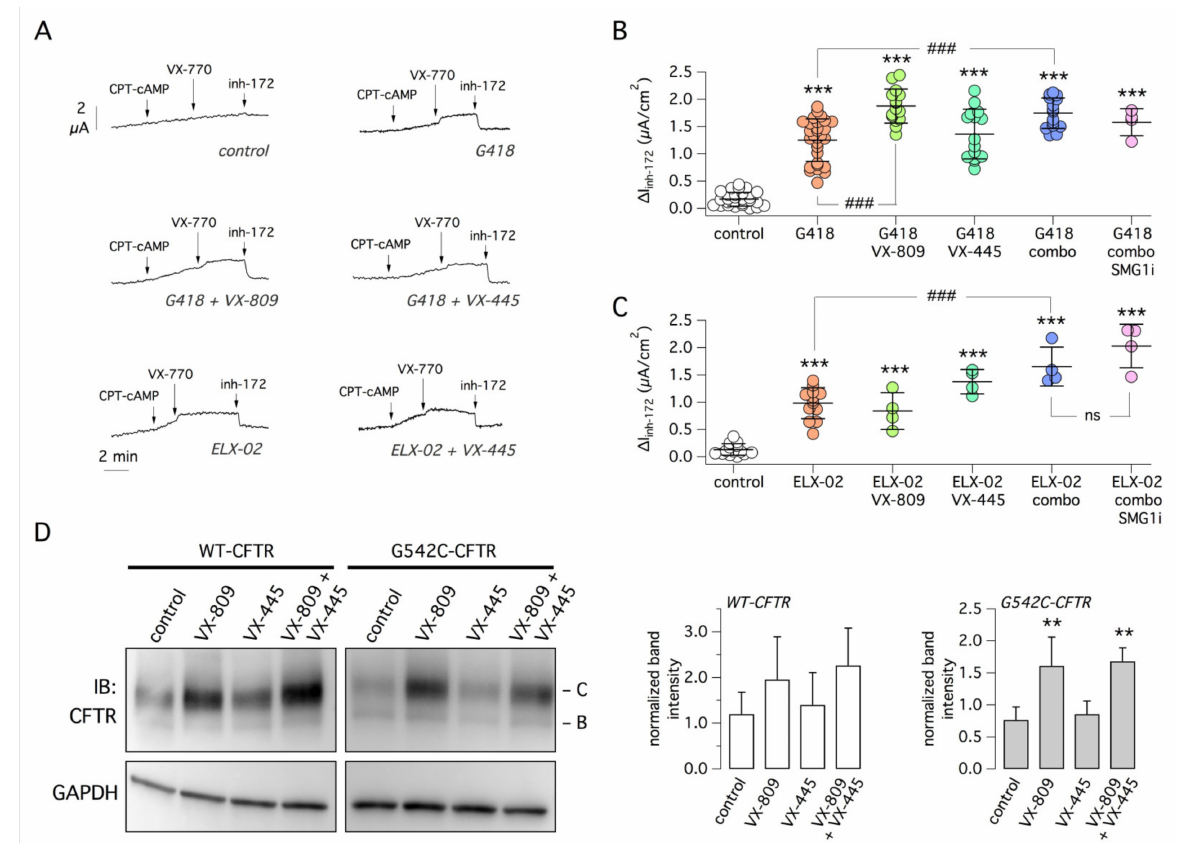
Figure 1. Pharmacological rescue of G542X-CFTR mutant. ( A ) Representative short-circuit current recordings from the 16HBE14o- bronchial epithelial cell line carrying the G542X mutation in the CFTR gene. Before recordings, cells were treated for 24 h with G418 (0.5 mg/mL) or ELX-02 (0.5 mg/mL) alone or in combination with VX-809 (1 µ M), VX-445 (5 µ M), the two correctors together (combo), with/without SMG1i (1 µ M). During recordings, cells were first stimulated with the membrane-permeable cAMP analog (CPT-cAMP, 100 µ M) and then with VX-770 (1 µ M), to induce CFTR activation. CFTR activity was then inhibited with inh-172 (10 µ M). Pharmacological rescue results in a higher CFTR activity as indicated by the larger amplitude of inh-172 effect. ( B ) Summary of data obtained with G418 as readthrough agent, with/without correctors and SMG1i. The scatter dot plot reports the amplitude of the current drop elicited by inh-172 for the indicated conditions. ***, p < 0.001 vs. control. ###, p < 0.001 vs. G418. ( C ) Summary of data obtained with ELX-02 as readthrough agent, with/without other compounds. ***, p < 0.001 vs. control; ###, p < 0.001 vs. ELX-02; ns, not significant. ( D ) Immunoblot analysis of wild-type and G542C-CFTR protein processing. The image (left) shows a representative Western blot experiment performed on lysates of HEK293 cells transiently transfected with wild-type or G542C-CFTR plasmids and treated for 24 h with VX-809 (1 µ M) and/or VX-445 (5 µ M). The B and C bands correspond to partially and fully glycosylated forms of CFTR protein. The bar graphs (right) summarize the C band intensity (normalized for GAPDH expression) from Western blot experiments. **, p < 0.01 vs. control ( n =